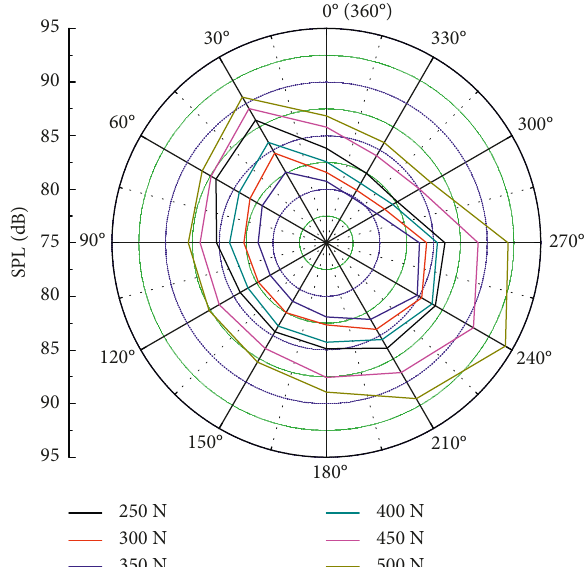
Figure 3: Radiation noise of the ceramic bearing with different